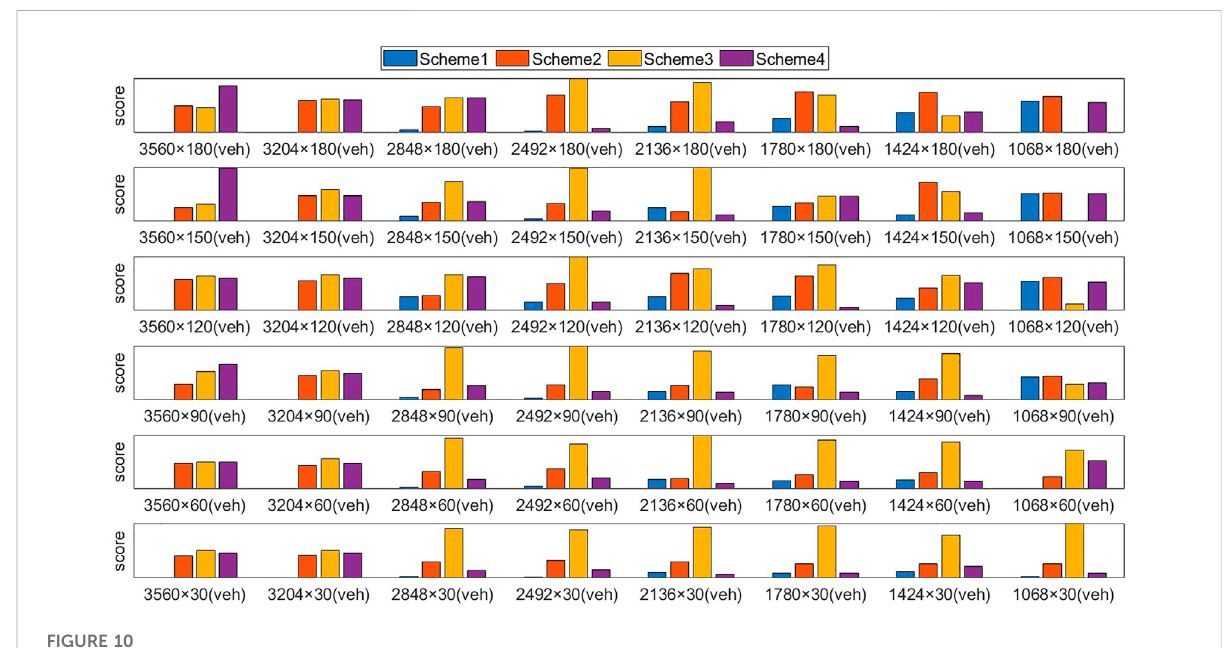
FIGURE 10 Comparison of the scores of each scheme under different traf fi c